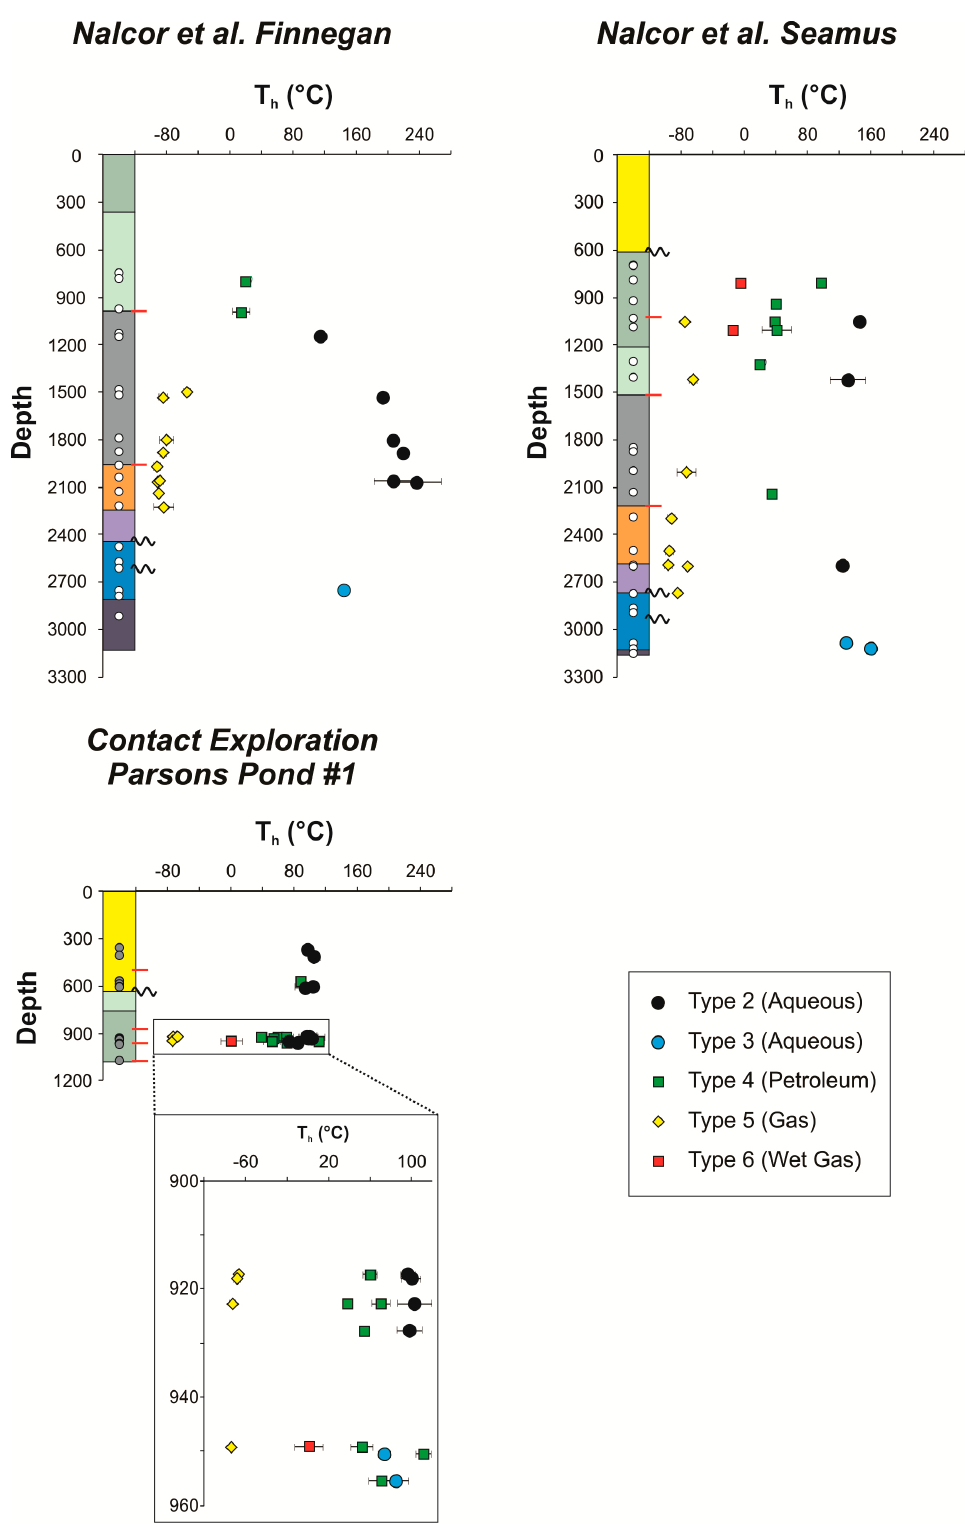
Figure 6. Homogenization temperatures of all inclusion types in Nalcor et al. Finnegan, Nalcor et al. Seamus and Parsons Pond #1 exploration wells plotted against depth. Symbols represent mean T h values; error bars represent standard deviation.